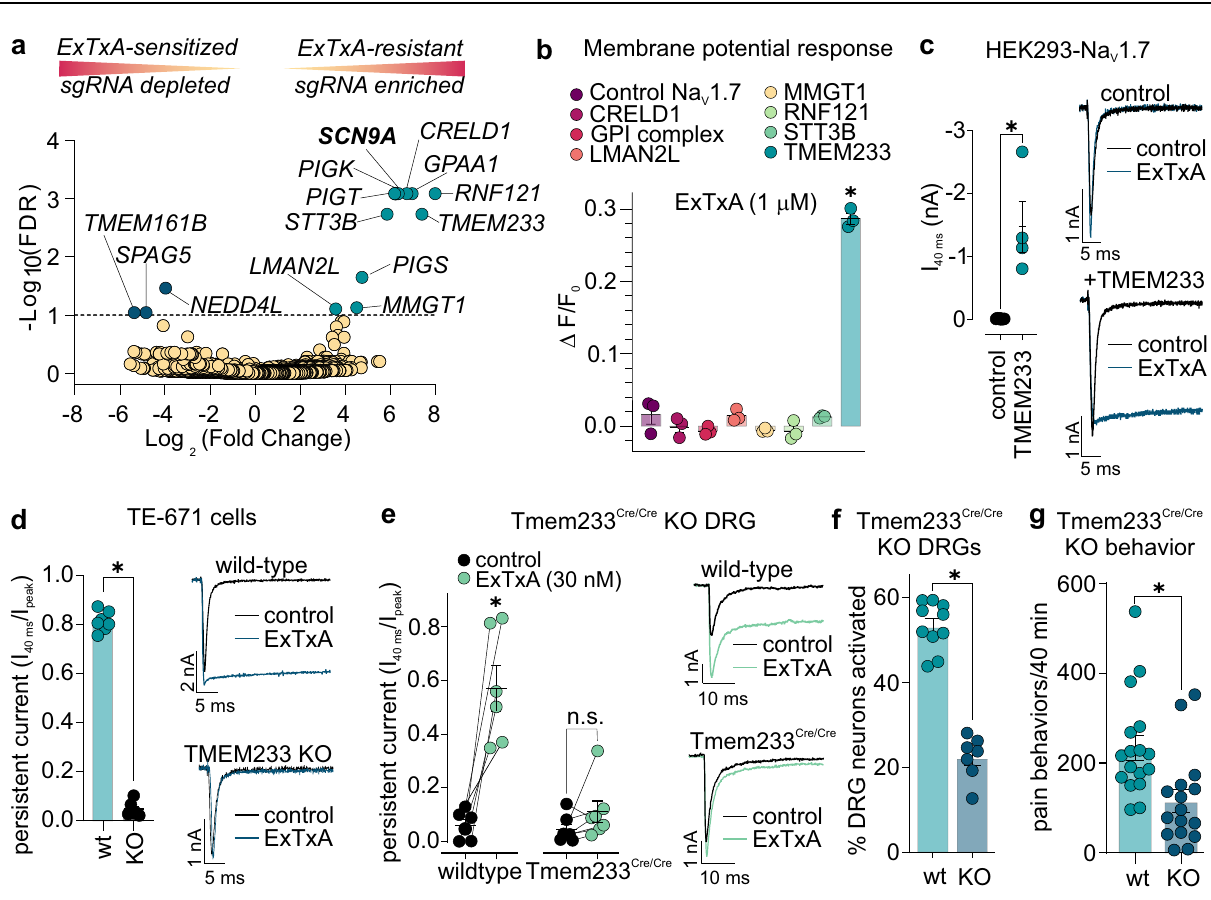
Fig. 3 | TMEM233 is required for ExTxA-induced inhibition of Na V 1.7 inactiva- tion. a LentiCRISPR-Cas9 TKOv3 screen showing depletion and enrichment of sgRNAs in control (veratridine, 5 μ M; ouabain, 20nM) and ExTxA-treated (ExTxA, 1 μ M; veratridine, 5 μ M; ouabain, 20nM) TE-671 cells. b ExTxA (1 μ M)-induced changeofmembranepotentialdye fl uorescence ( Δ F/F 0 )inHEK293-Na V 1.7cellsco- transfected with CRELD1 , GPI complex ( GPAA1, PIGU, PIGS, PIGK, PIGT ), LMAN2L , MMGT1 , RNF121 , STT3B ,and TMEM233 . c Persistentcurrents(I 40 ms ;nA)inducedby ExTxA (1 μ M) in HEK293-Na V 1.7 cells (control) and HEK293-Na V 1.7 cells co- transfectedwithTMEM233(TMEM233).Rightpanels,representativecurrenttraces; depolarization to − 20mVfrom − 90mV holding potential. d